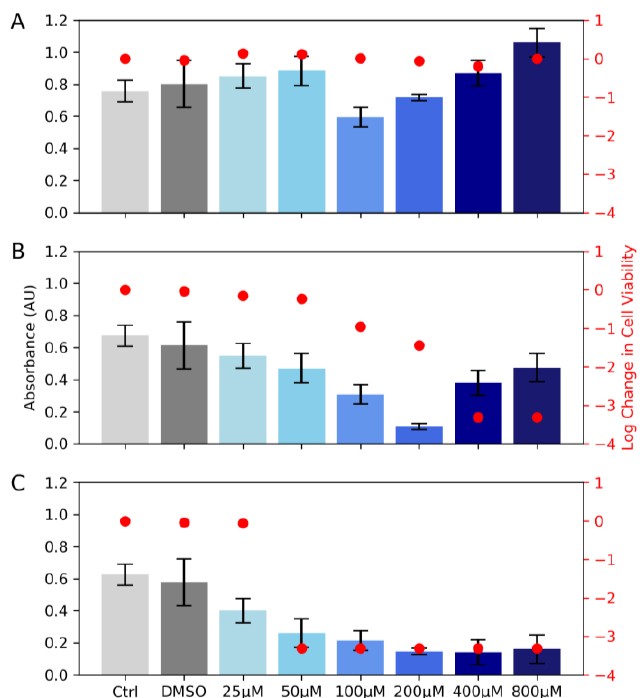
Figure 2. Concentration evaluation of gallic acid ( A ), methyl gallate ( B ), and tannic acid ( C ) with absorbance (left — gray/blue) indicating biofilm formation and log change in cell viability (right — red) reporting the toxicity of the small molecule.